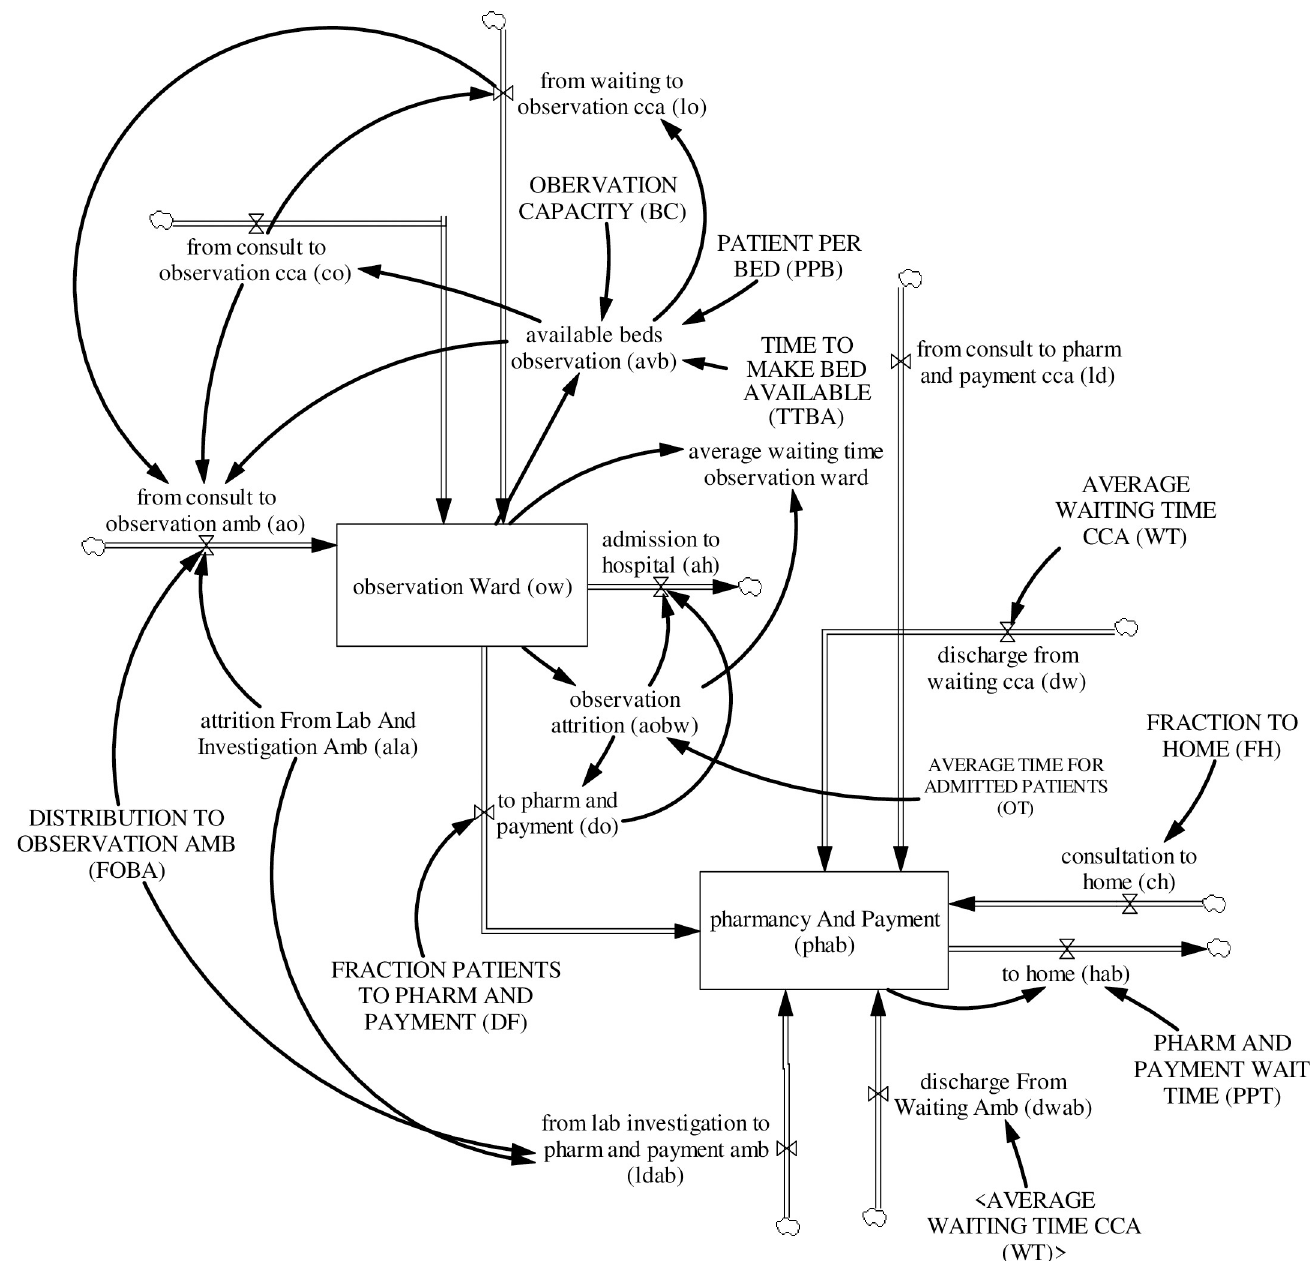
Fig 8. Observation ward and discharge area